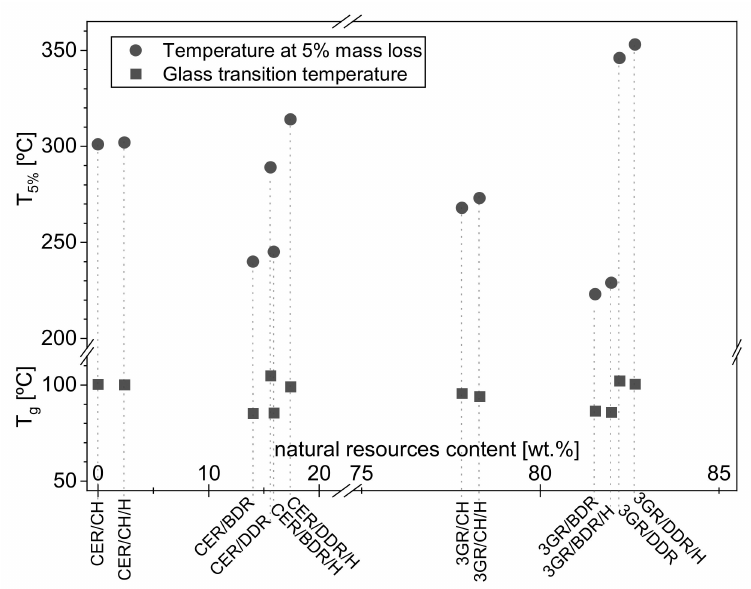
Figure 5. Content of natural resources in prepared coatings and their glass transition temperature (T g ) and temperature at 5% mass loss (T 5% )